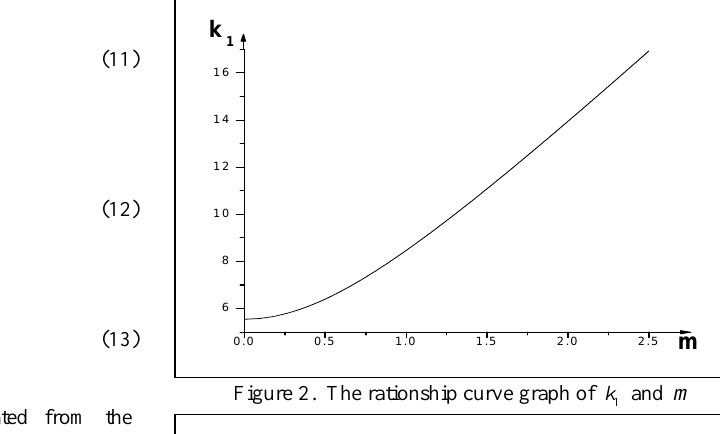
Figure 2. The rationship curve graph of